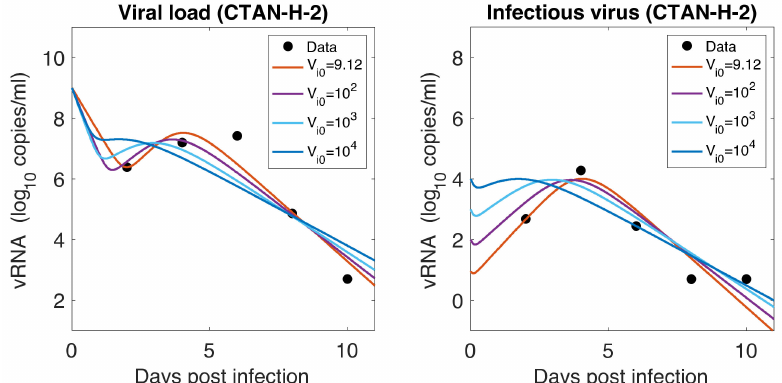
Figure 5. Role of Initial infectious viruses. Fitting data with initial virus at the infection site ( V i 0 ) estimated vs fixed. Shown here are two representative animals from each of the two groups infected with F13-E SARS-CoV-2 and CTan-H SARS-CoV-2. The best-fit curves corresponding to V i 0 = 9.25 PFU/mL (F13-E-2) and V i 0 = 9.12 PFU/mL (CTan-H-2) were obtained by allowing V i 0 to be estimated by data fitting process, while other best-fit curves were obtained by fixing the values of V i 0 at 10 2 , 10 3 , and 10 4